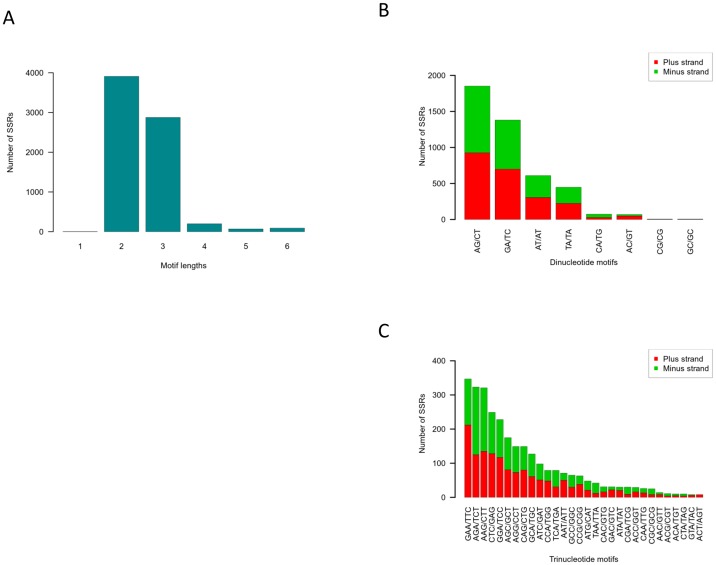
SSR length and motif distribution.The number of mono- to hexanucleotide SSR motifs was counted (A). The nucleotide compositions of the most frequent motifs (di- and trinucleotide motifs) was determined for each type and is illustrated in a bar plot for dinucleotide (B) and trinucleotide (C) motifs. Motifs that are reverse-complementary were plotted one above the other as “plus strand” (red) and “minus strand” (green).